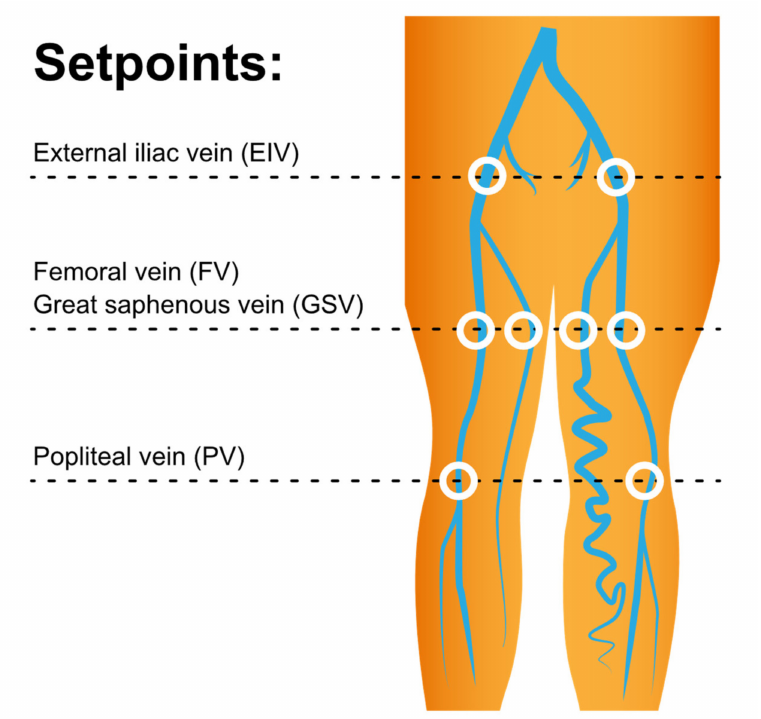
Figure 2. QFlow scan was performed at three levels to obtain the cross-sectional images of the vascular structure of the lower extremity. A postprocessing analysis drew the region of interest on the vascular lumens at the setpoints of both external iliac veins, femoral veins, greater saphenous veins, and popliteal veins. Each setpoint of QFlow analysis can generate eight flow-related